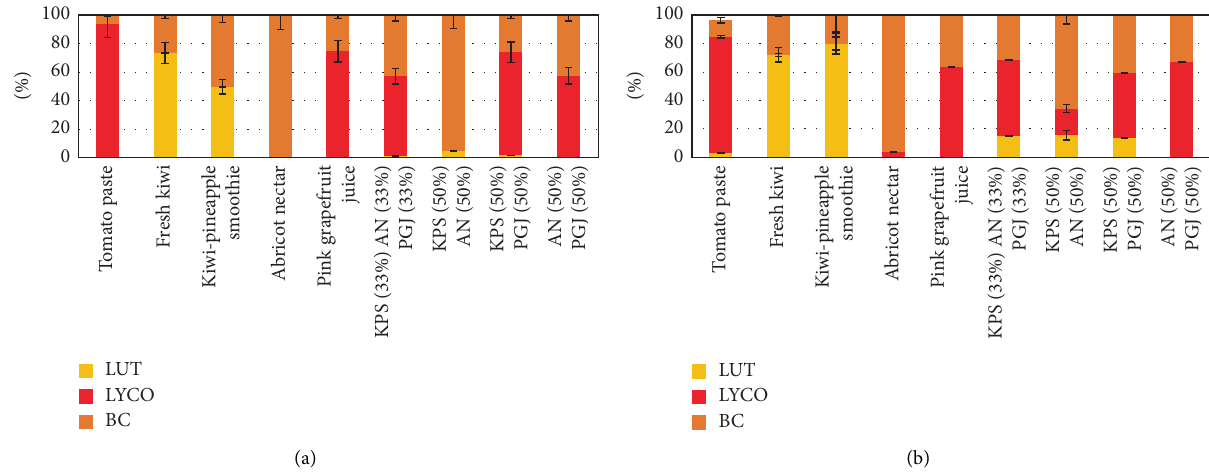
Figure 7: Relative proportion of lutein (LUT), lycopene (LYCO), and β -carotene (BC) from (a) HPLC and (b) spectrophotometry+MCR-